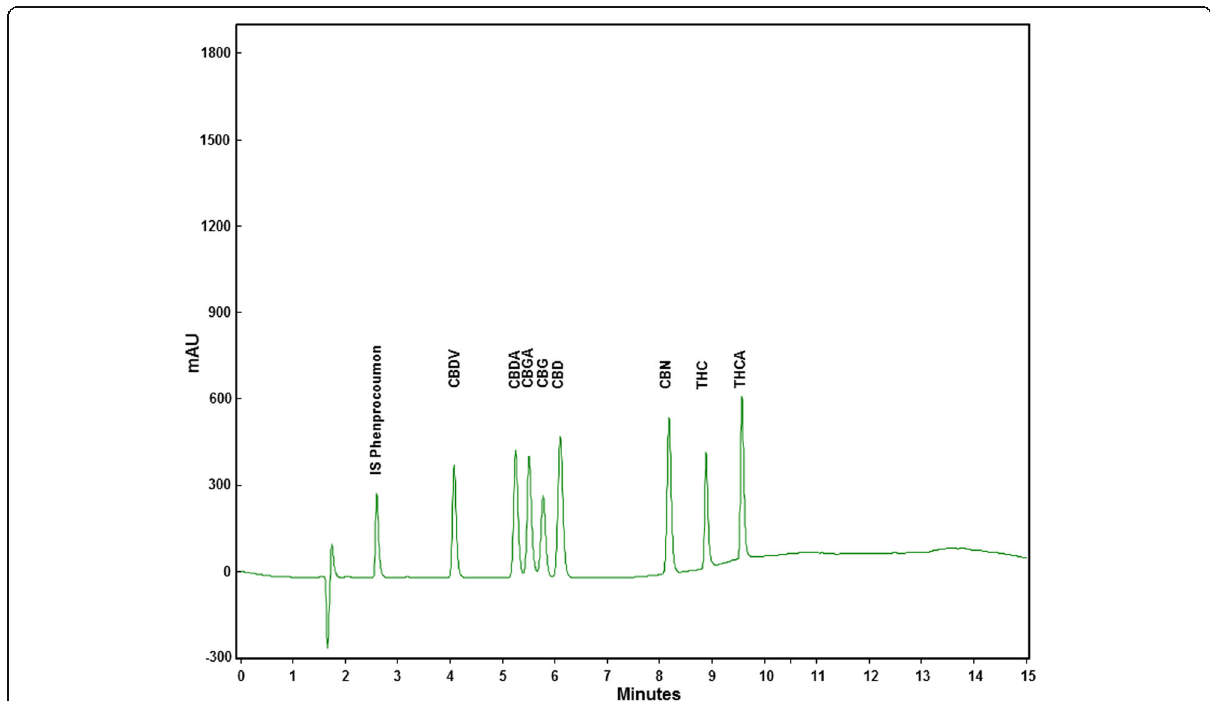
Fig. 2 UV chromatogram of Cal 2 recorded at λ = 220